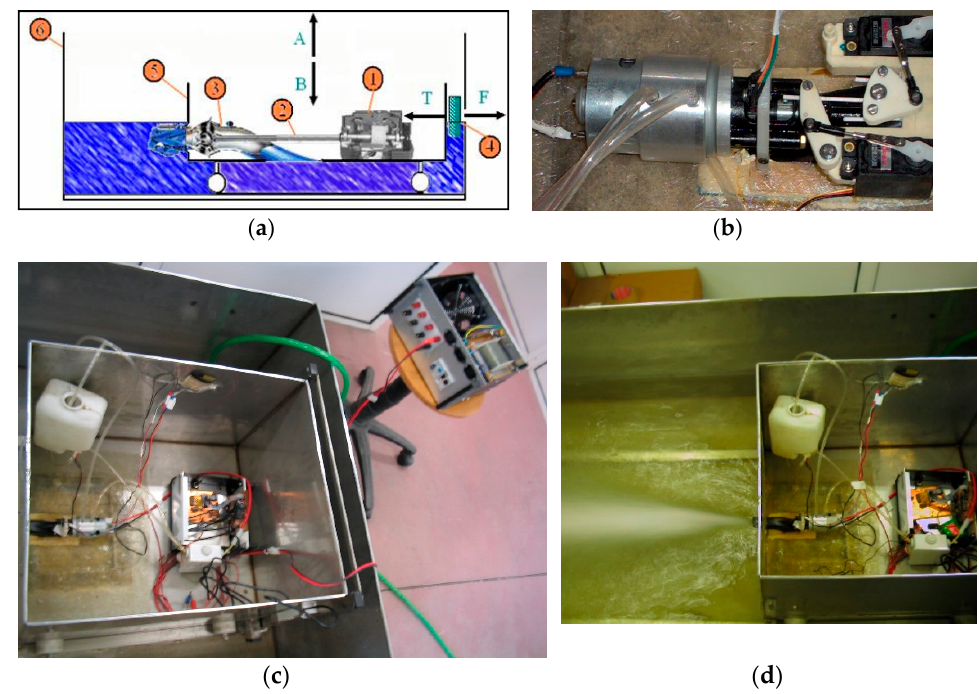
Figure A1. The boat electric propulsion system testbed: principle of operation ( a ), powertrain with speed sensor ( b ), testbed in action in pictures ( c , d ).